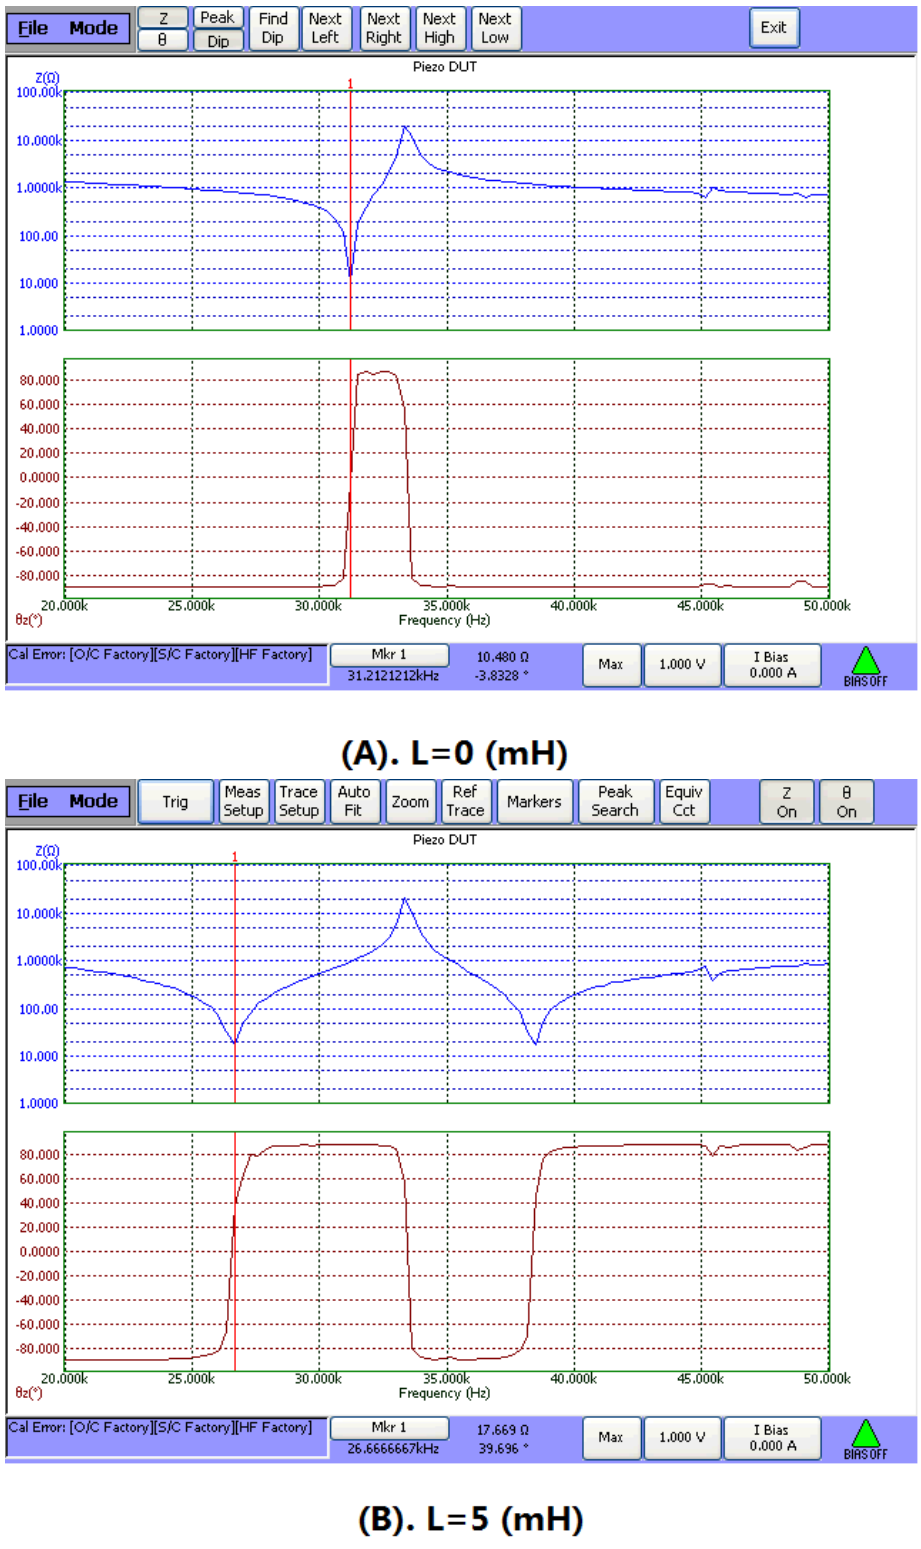
Figure 13. Measured frequency response of the input electric impedance of a sandwich piezoelectric transducer. ( A ) L = 0 (mH); ( B ) L = 5 (mH).